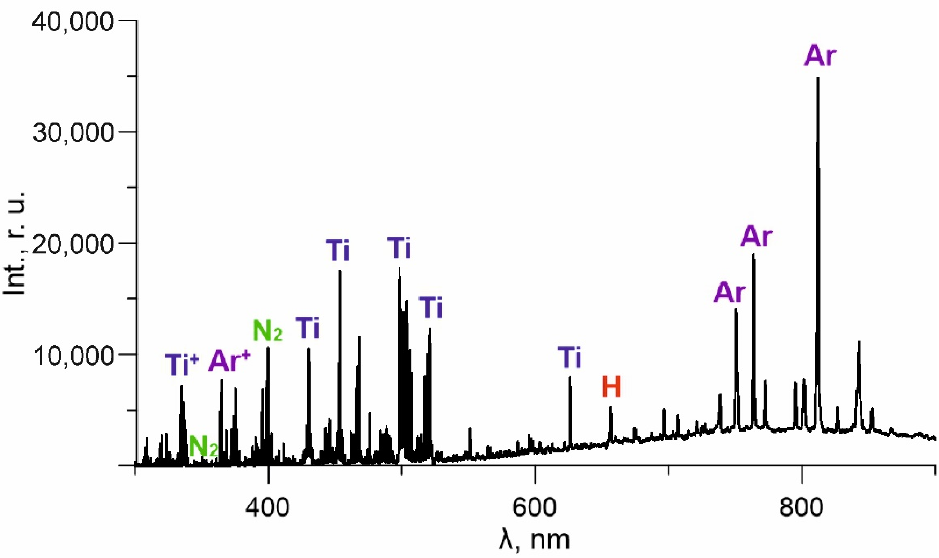
Figure 3. Optical spectra of discharge plasma.